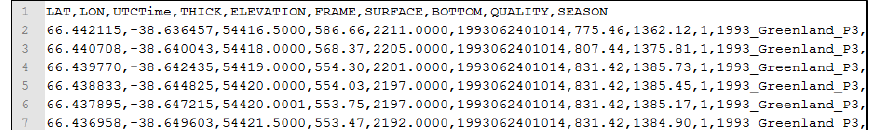
Figure 10. The information of CReSIS data in CSV format.